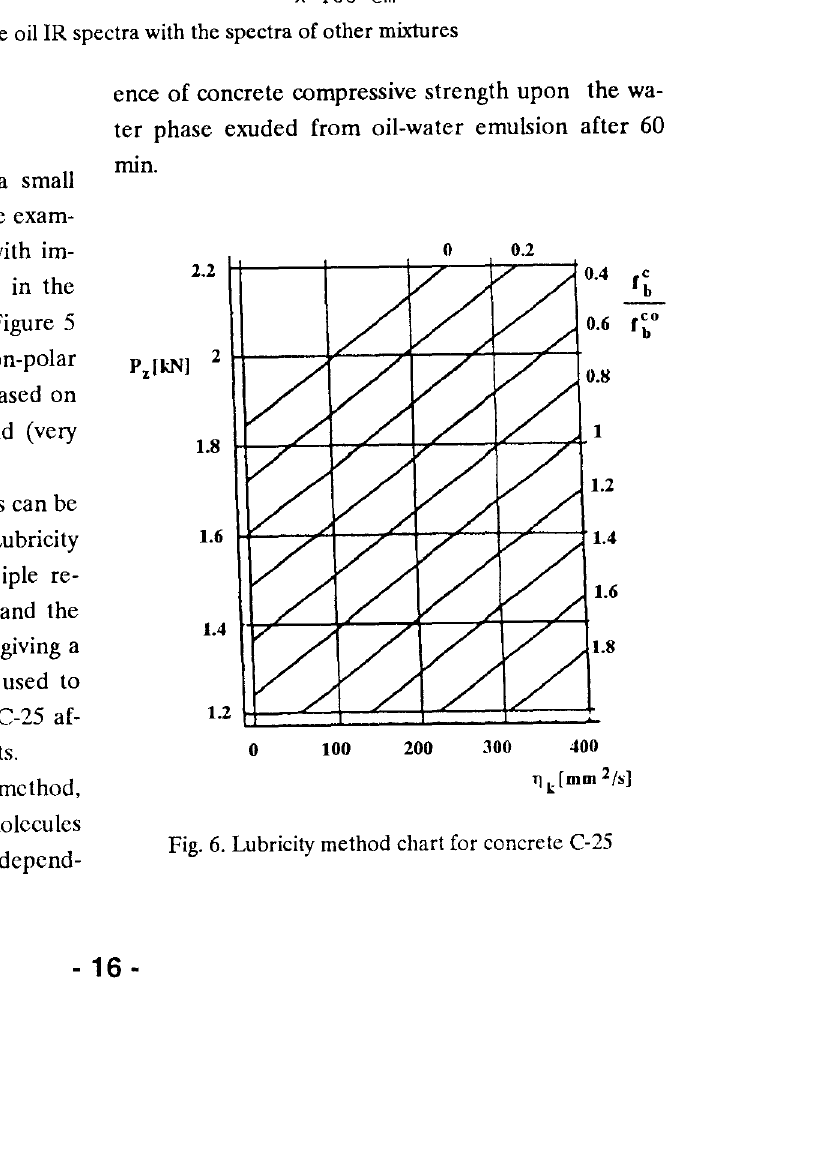
Fig. 5. Comparison of vase line oil IR spectra with the spectra of other mixtures ence of concrete compressive strength upon the wa